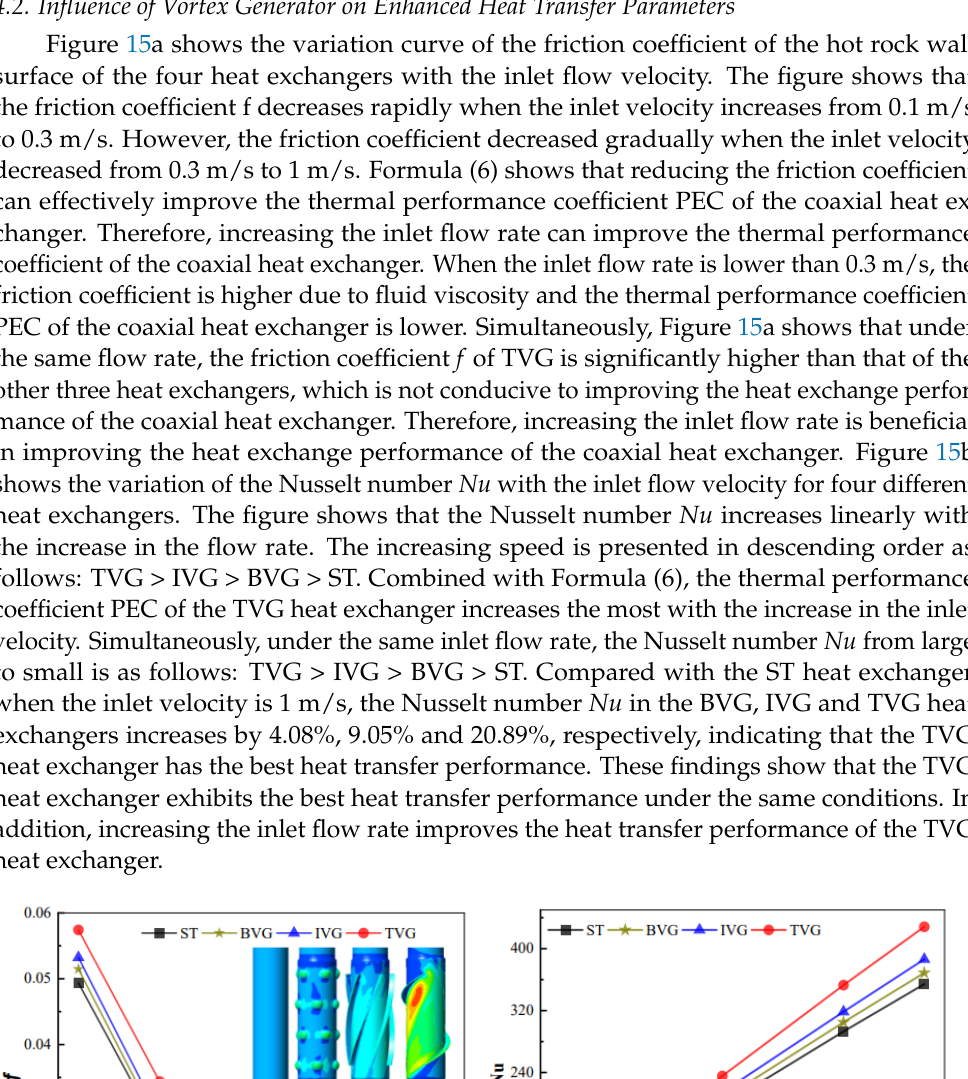
TVG Figure 16. Influence of inlet flow rate on PEC of heat exchangers with vortex generators.